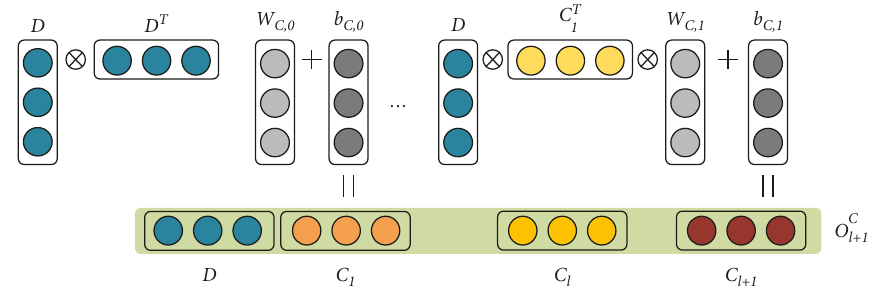
Figure 3: The structure of cross layer in Double Cross